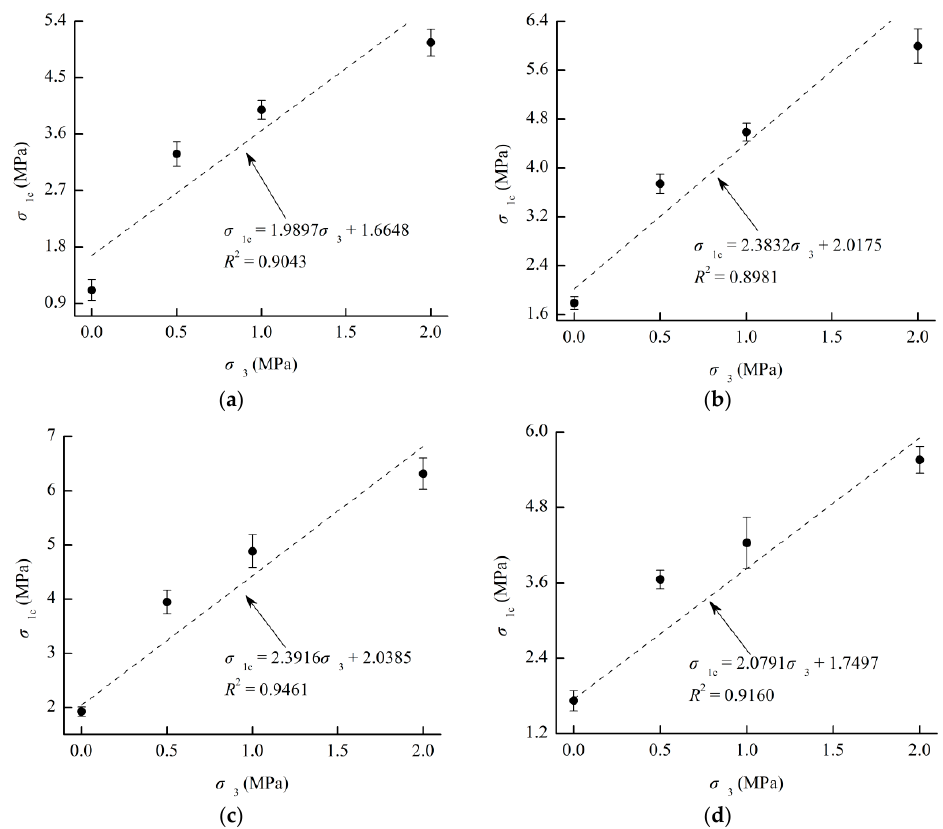
Figure 10. Relationship between the peak strength and confining pressure of CPB specimens with different Talbot indexes. n = 0.2 ( a ); n = 0.4 ( b ); n = 0.6 ( c ); n = 0.8 ( d ). Table 6. Relationships between the peak strength and Talbot index of CPB specimens under different confining pressures.